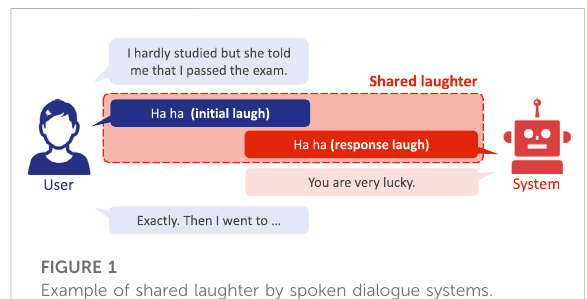
FIGURE 1 Example of shared laughter by spoken dialogue